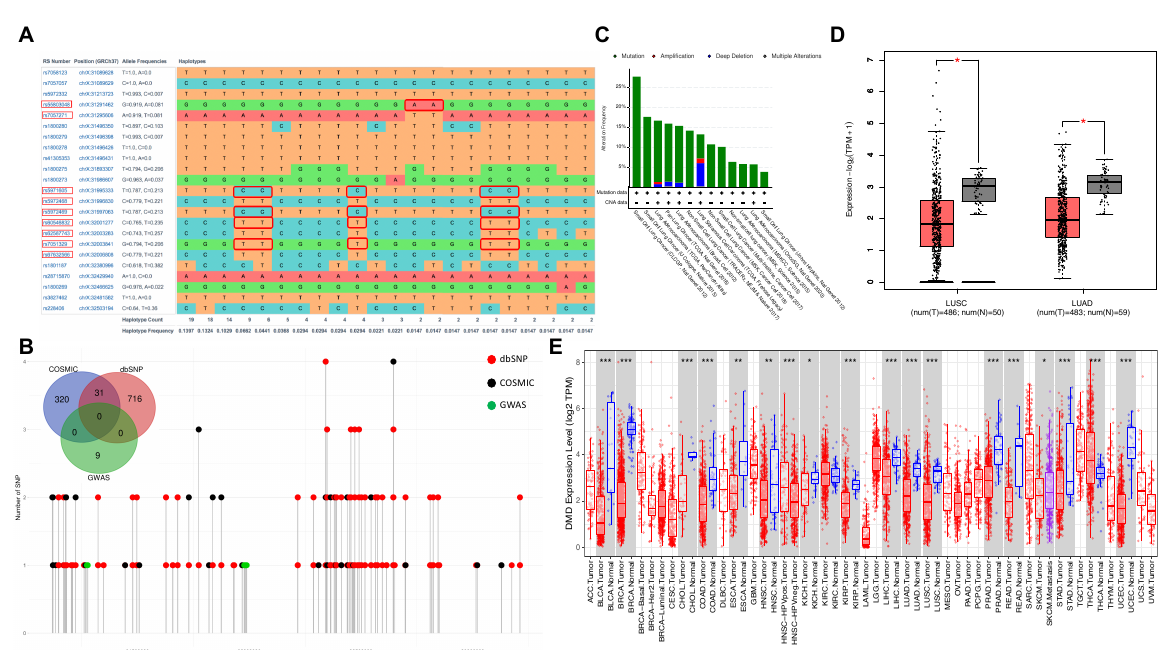
Figure 2. Genetic alteration and gene expression of DMD. ( A ) Haplotype analysis of identified SNPs in DMD. ( B ) Genomic position of identified SNPs, pathogenic SNPs in cancer and Duchenne muscular dystrophy in DMD. ( C ) The alteration profile of DMD in 3163 lung cancer samples reported in cBioportal. ( D ) Expression of DMD in TCGA-LUAD and TCGA-LUSC cohort. ( E ) Pan-cancer analysis of differential DMD expression. The significant p value was indicated as 0 ≤ *** < 0.001 ≤ ** < 0.01 ≤ * <